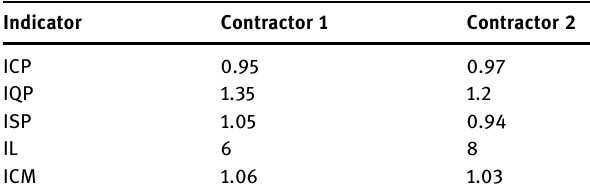
Table 10: Monthly indicators values for two contractors